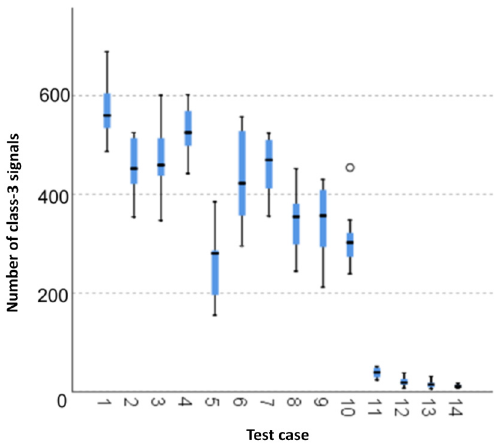
Figure 8. Graphic presentation of the Kruskal–Wallis test results for independent samples: number of class-3 signals.